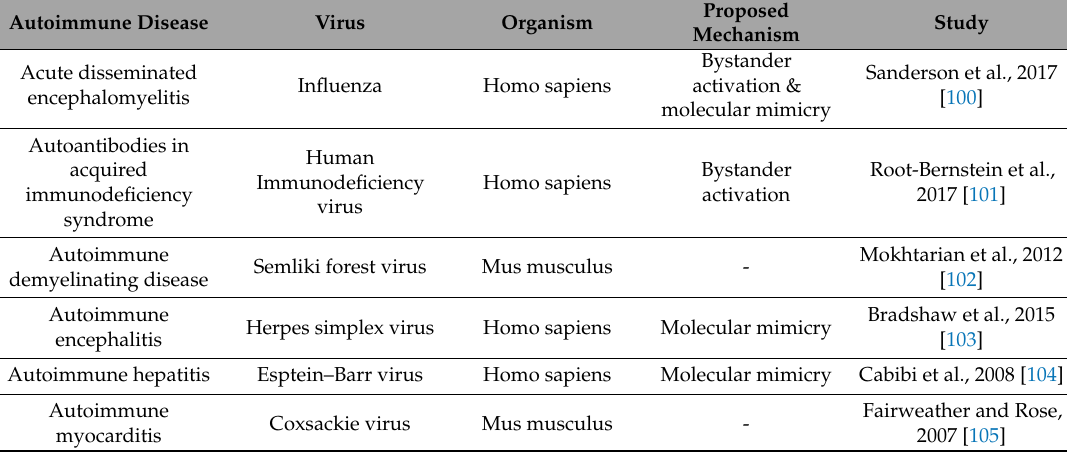
Table 1. Examples of viral infections that have been linked to autoimmune diseases in di ff erent